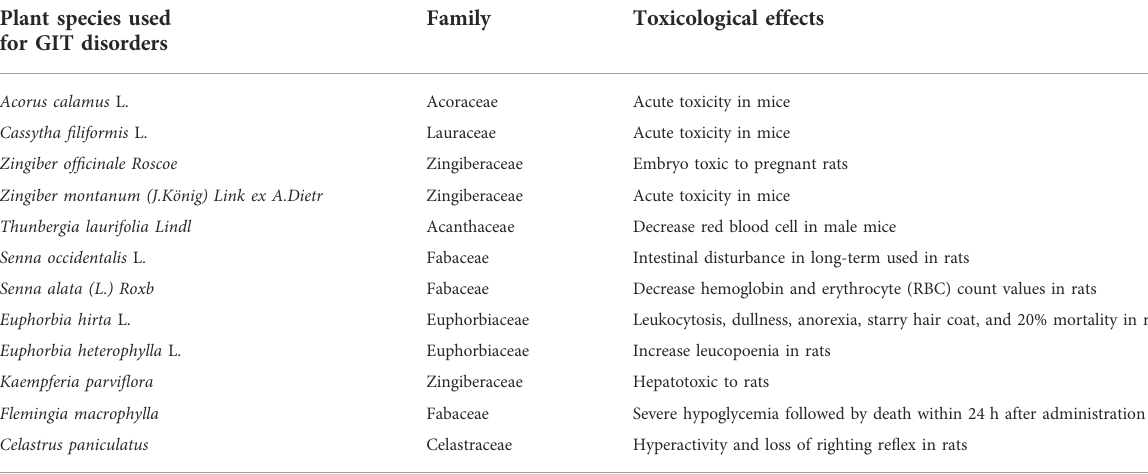
TABLE 2 A number of side effects of the plant species used for different GIT disorders (Tangjitman et al., 2015). Plant species used for GIT